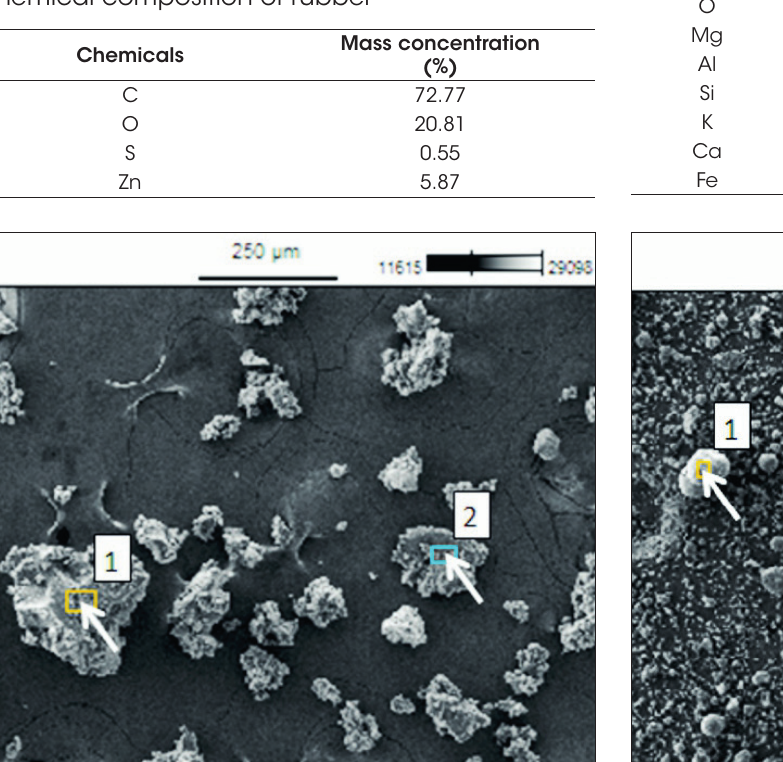
Chemical composition of